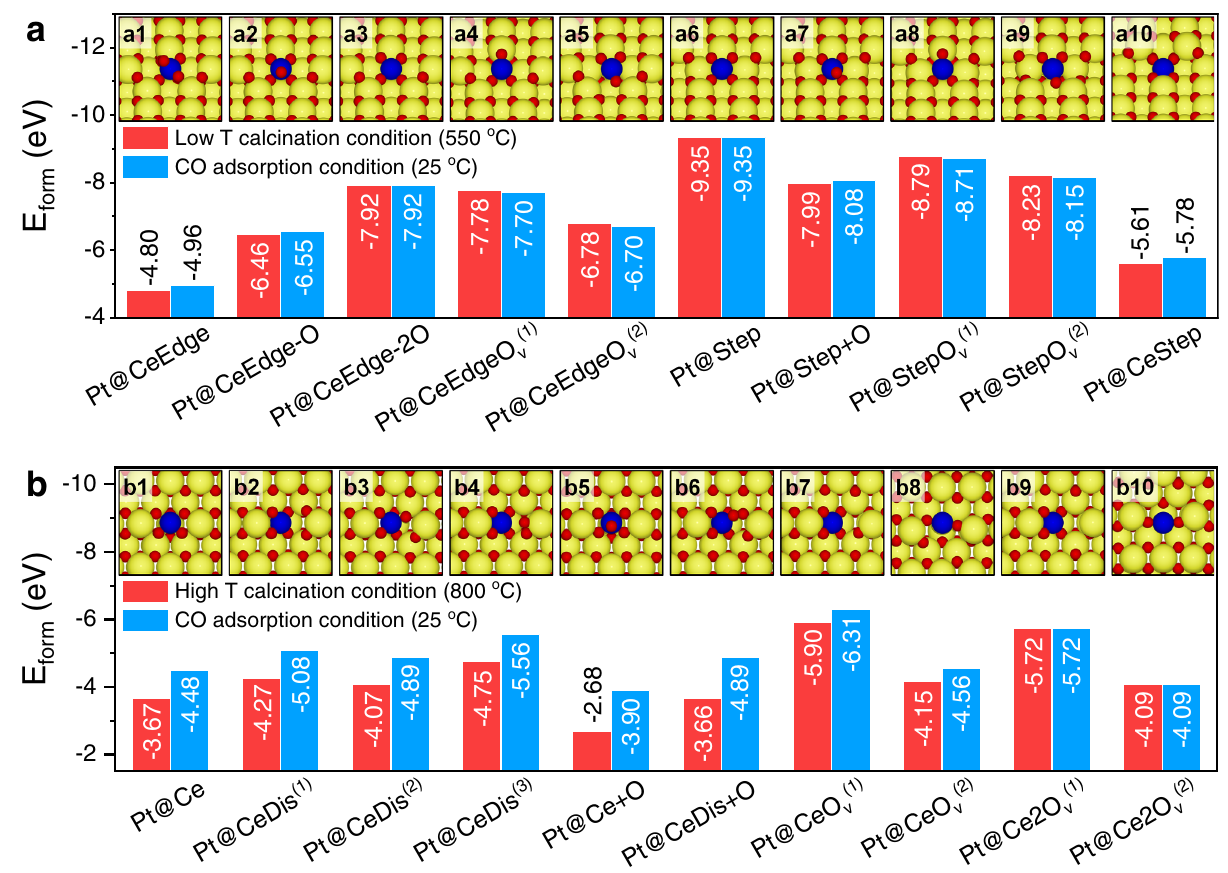
Fig. 5| Determinationof Pt 1 con fi gurationsonCeO 2 throughDFTcalculations. The formation energy ( E form ) of the considered Pt 1 con fi gurations on CeO 2 (110) under different conditions, i.e., low-temperature (Low T) calcination condition (550°C, 0.21atm O 2 pressure), high-temperature (High T) calcination condition (800°C, 0.21atm O 2 pressure), and CO adsorption condition (25°C, 10 − 20 atm O 2